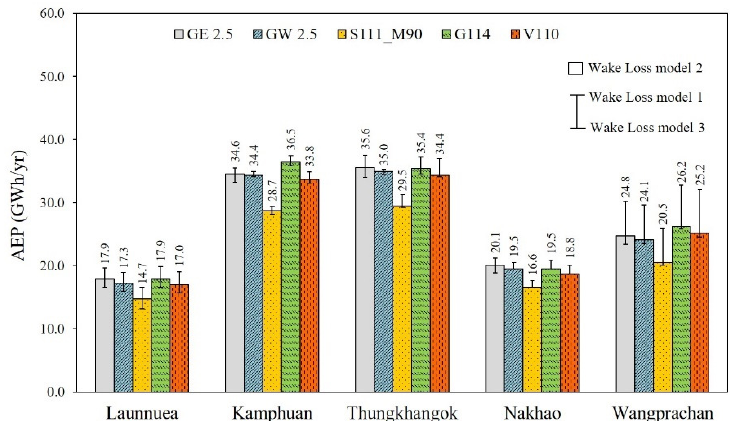
Figure 12. Estimated annual energy productions of 10-MW VSPP wind power plants at the potential sites of development.